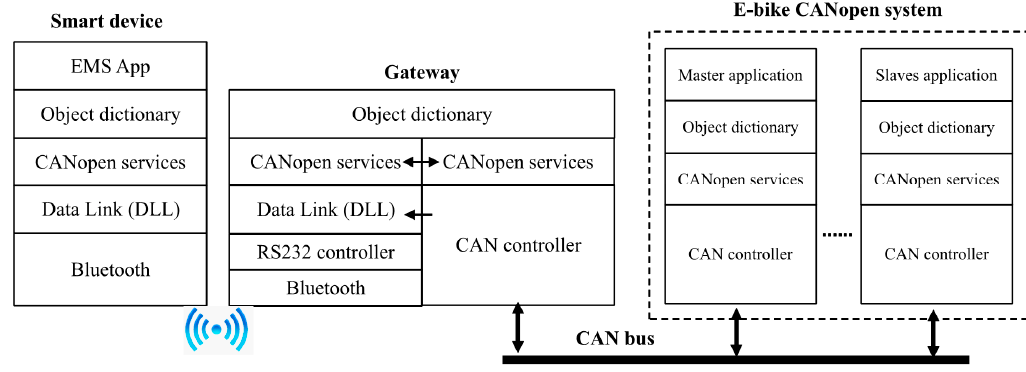
Figure 3. Energy monitoring system (EMS) architecture.